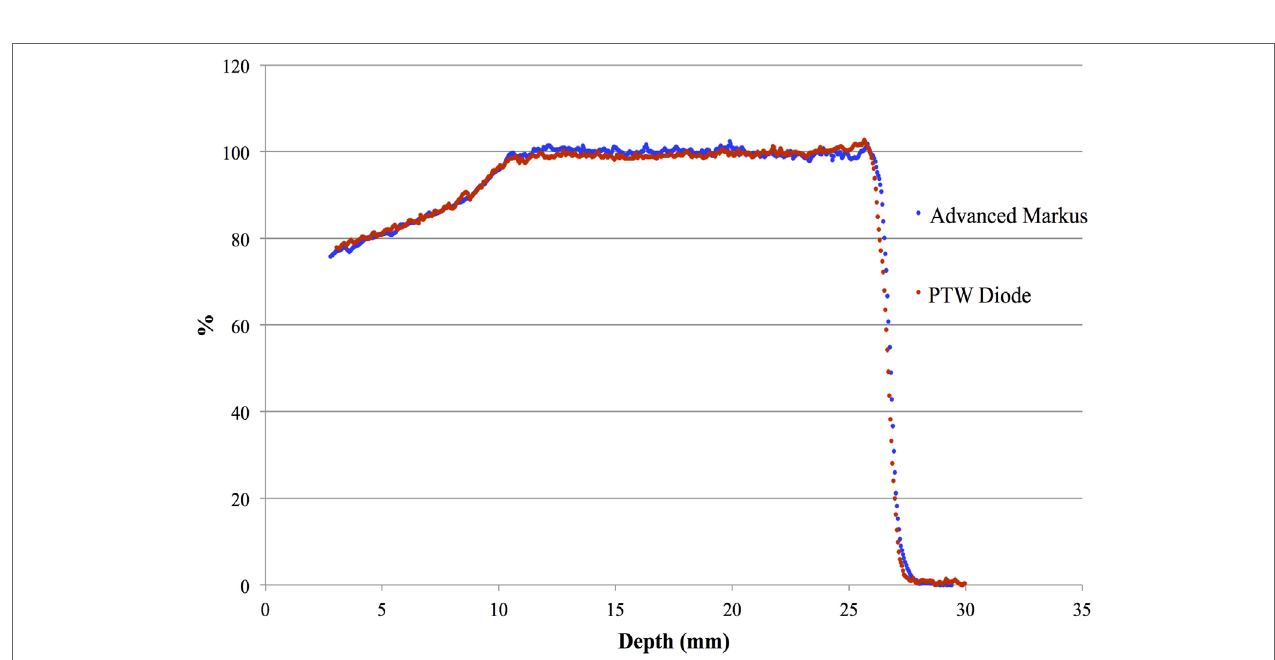
FIgURe 4 | Central axis depth–dose distribution of a modulated clinical proton beam measured by the PTW diode PR 60020 and the Advanced Markus Chamber. This picture reproduced with the permission of the authors.